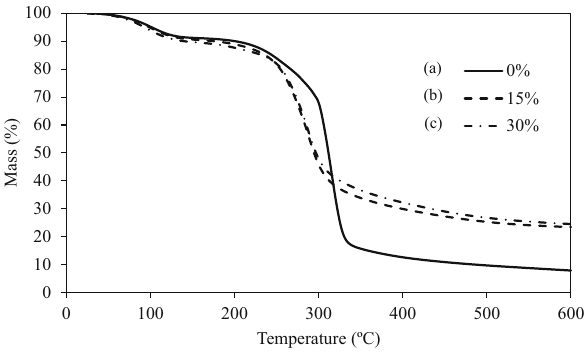
Figure 4: Thermogravimetric curves of ( a ) neat starch, ( b ) 15% w/w starch/CNP, and ( c ) 30% w/w starch/CNP fi